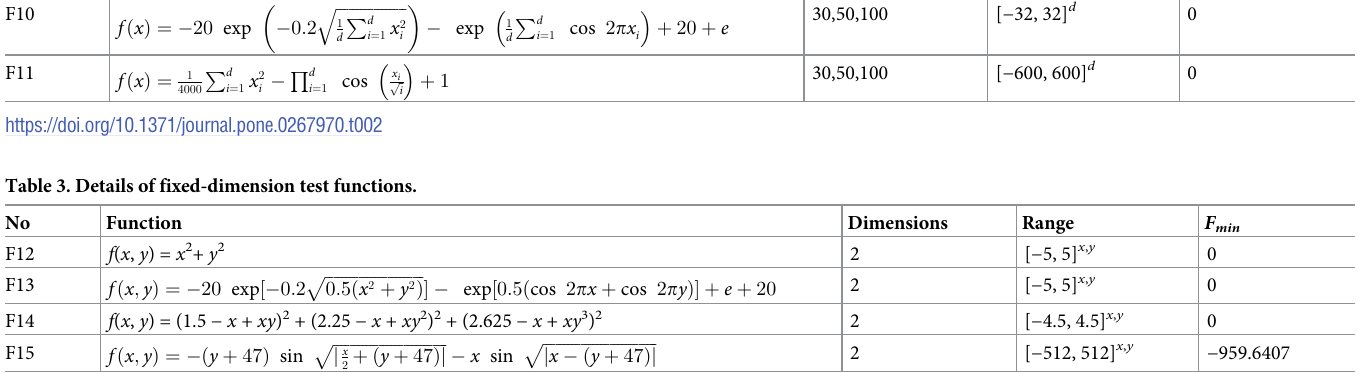
p j x (cid:0) ð y þ 47 Þj